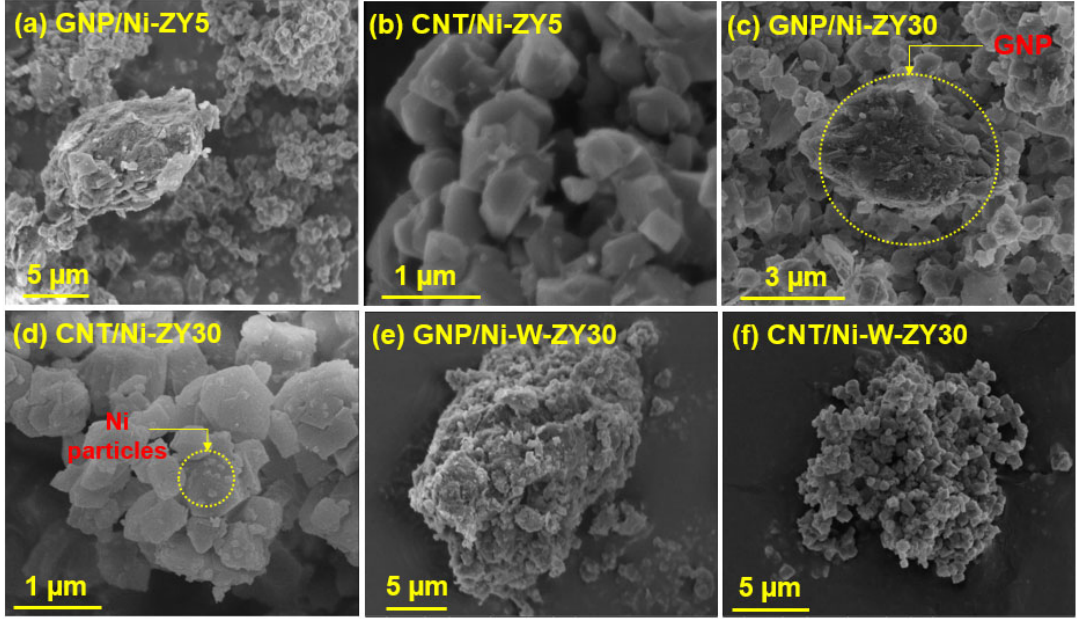
Figure 3. HR ‐ SEM images ( a – f ) obtained for the prepared catalysts. Figure 3. HR-SEM images ( a – f ) obtained for the prepared catalysts.